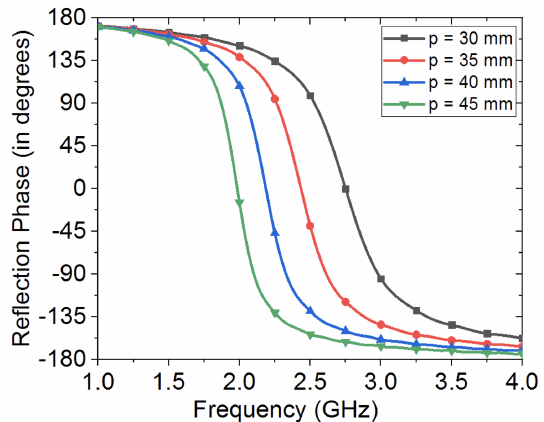
Figure 15. Effect of metallic patch size on operational in-phase reflection frequency band of the HIS structure. Note that periodic boundary conditions were applied in order to mimic a periodic HIS structure. Note that gap between patches, g , was kept fixed here as 2